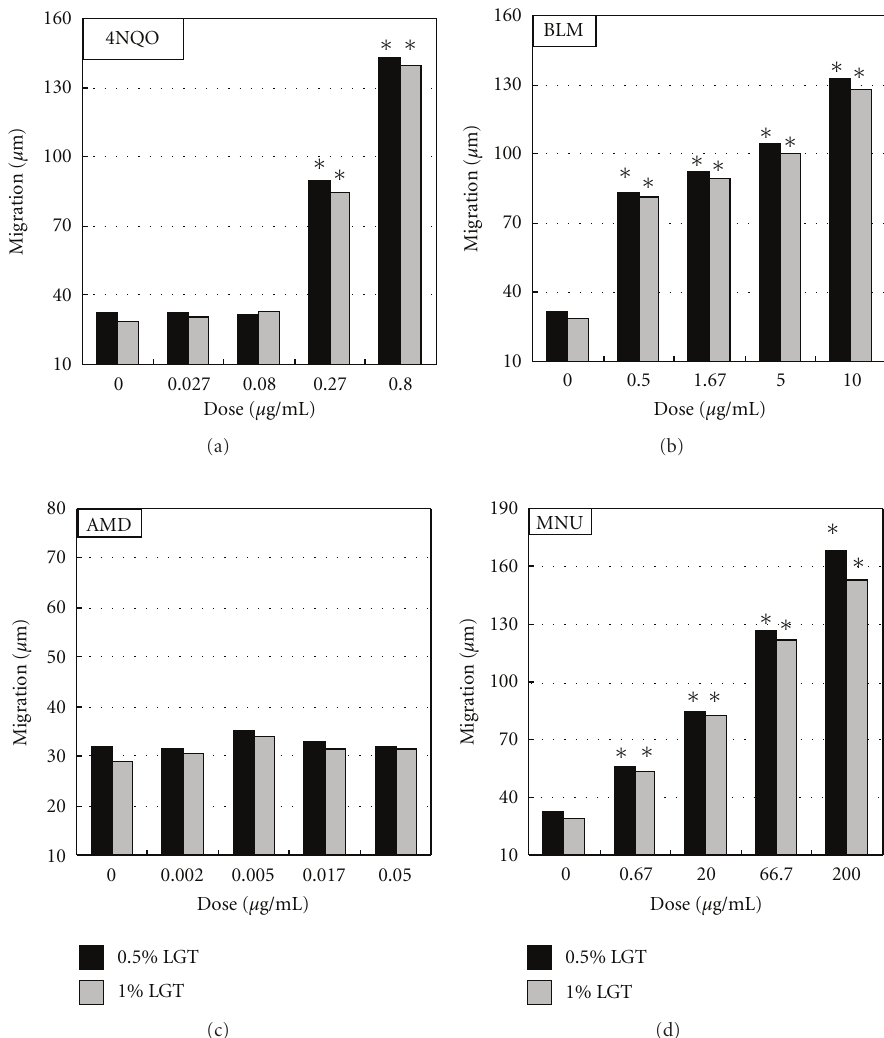
Figure 4: Comet assay in 0.5% LGT and 1% LGT. Chinese hamster CHO cells were exposed to each chemical mutagen for 1 h, and then slides for Comet assay were prepared immediately after the exposure. Electrophoresis was conducted at pH > 13. 4NQO, 4-nitroquinoline-1-oxide; AMD, actinomycin D ∗ Significant di ff erence from untreated control: P < .